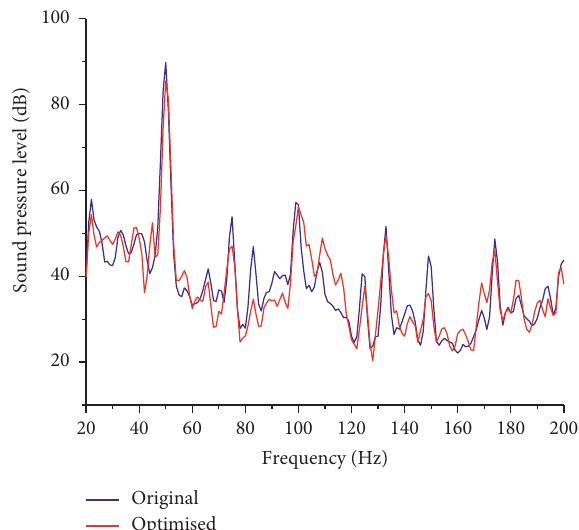
Figure 19: Original and optimized sound response curve.